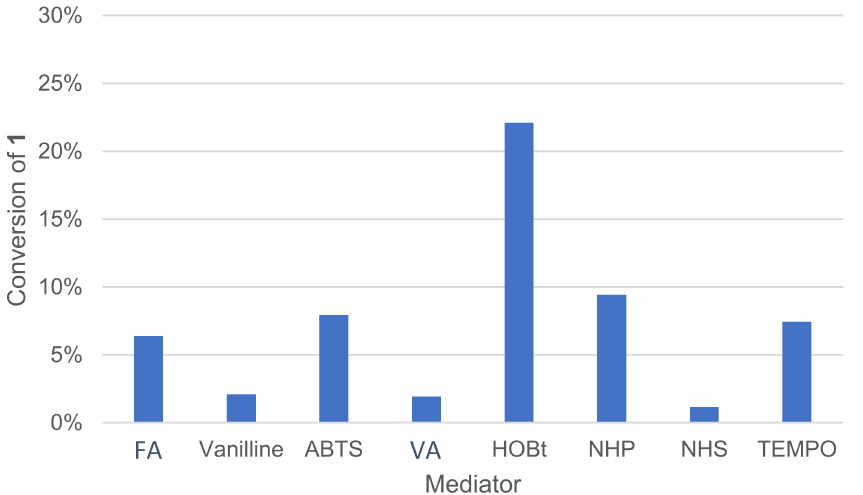
Figure 8. Effect of the mediator type on the conversion of 1 in the laccase-catalyzed oxidation (LA 10% w/w , mediator 20 mol%, acetate buffer pH5 0.25 M, O 2 atmosphere, incubation for 24 h, 40 ◦ C, 200 rpm). NPH: N-hydroxyphthalimide, NHS: N-hydroxysuccinimide, VA: violuric acid, FA: ferulic